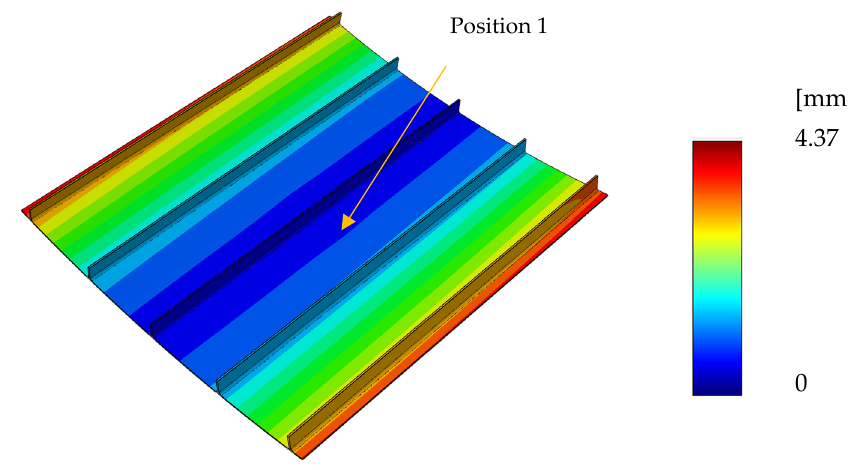
Figure 9. Process-induced distortion at the end of the process.